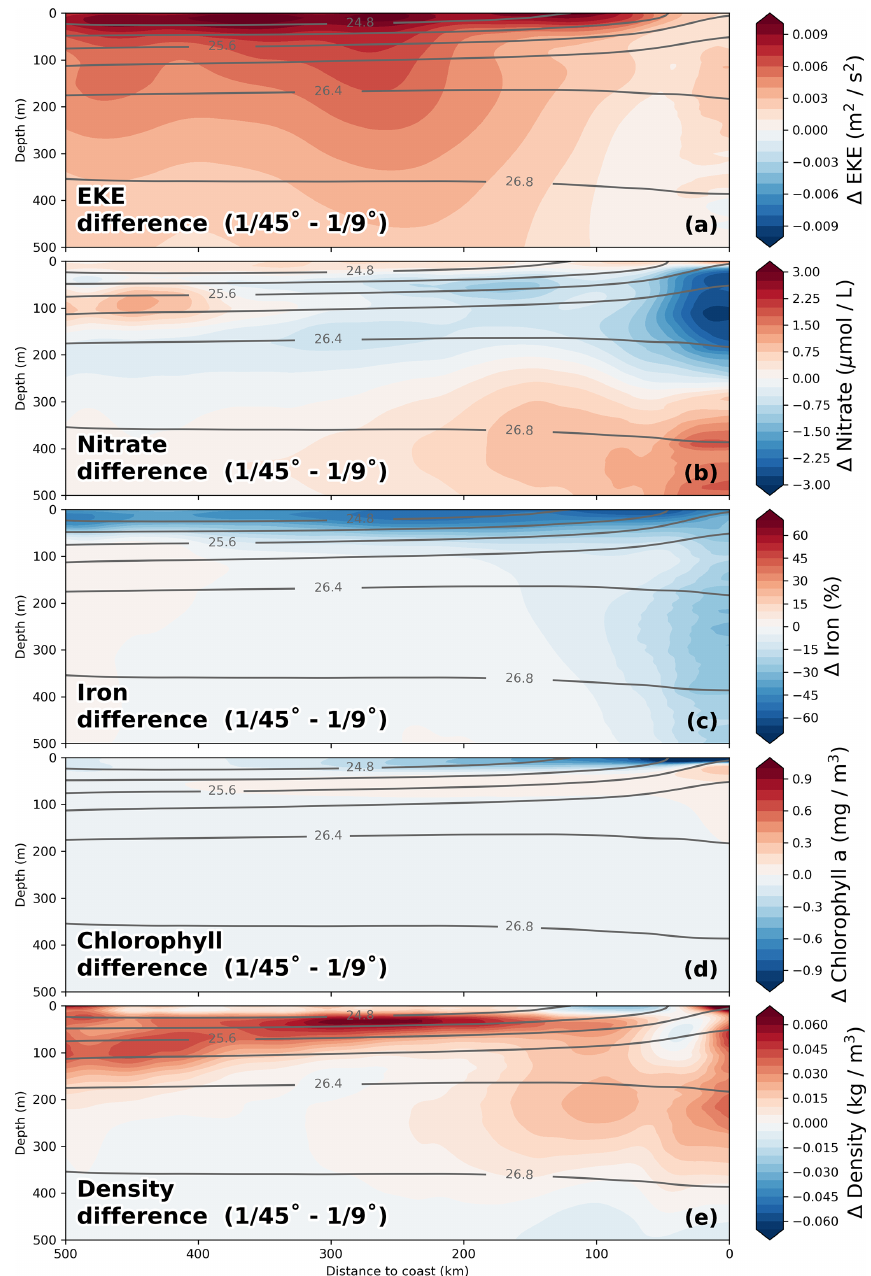
Figure 8. Relative differences in (a) nitrate, (b) iron, (c) chlorophyll, (d) temperature, and (e) eddy kinetic energy (EKE) between the 1 / 9 and 1 / 45 ◦ simulations calculated as (cid:49)X = X 1 / 45 – X 1 / 9 . EKE was calculated relative to a 6-month running mean. All fields were averaged on depth levels in the along-shore direction with 25km cross-shore bins in a coastal band of 500km width between 10.5 and 17.5 ◦ S over the period 2015–2016. Gray lines represent potential density averaged over the 1 / 9 and 1 / 45 ◦